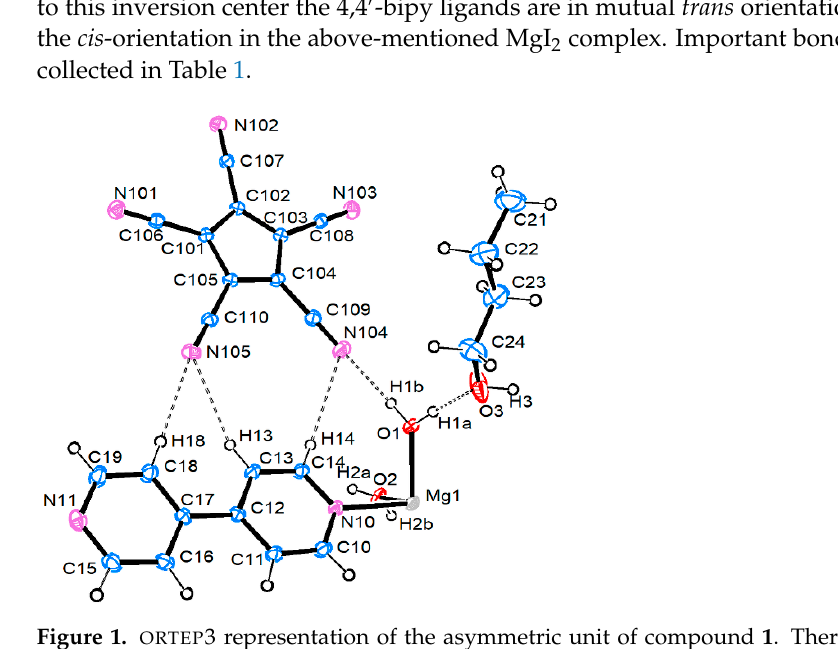
Figure 1. ORTEP 3 representation of the asymmetric unit of compound 1 . Thermal ellipsoids are drawn at the 30% probability level.